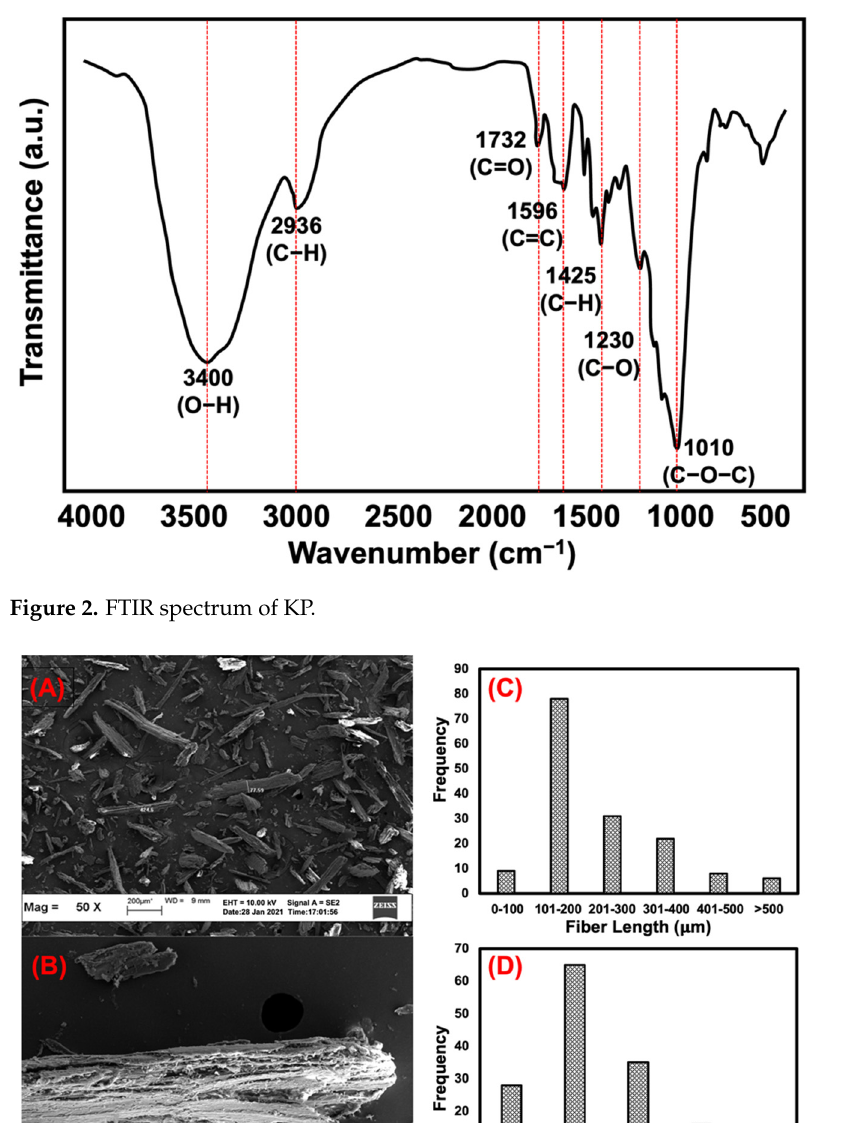
Figure 2. FTIR spectrum of KP.